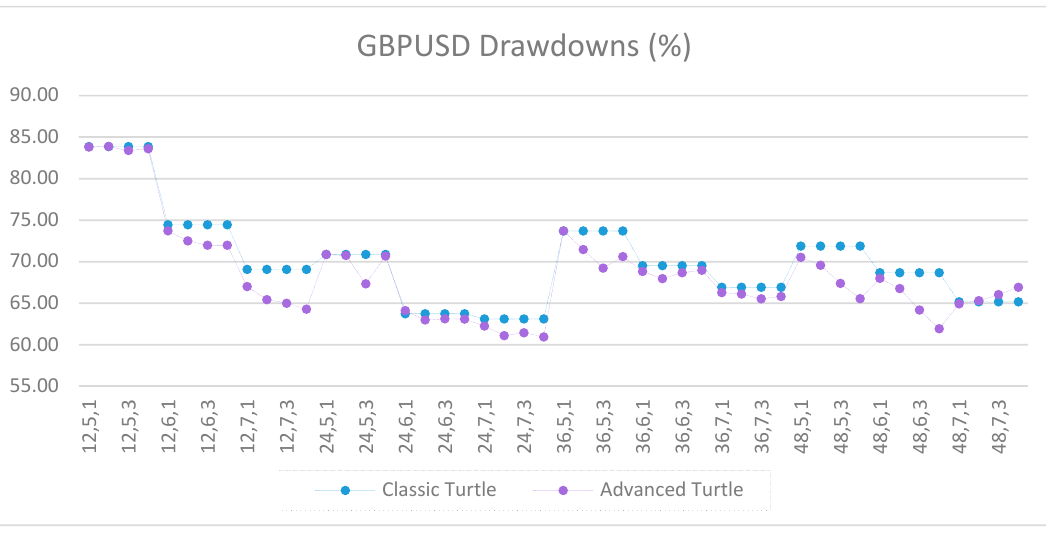
Figure A54. Drawdowns of GBPUSD as percentage of equity between the classic and the advanced Turtle systems for every combination of N, X, Y for the slow parameters (80, 160), where X ≥ 5.